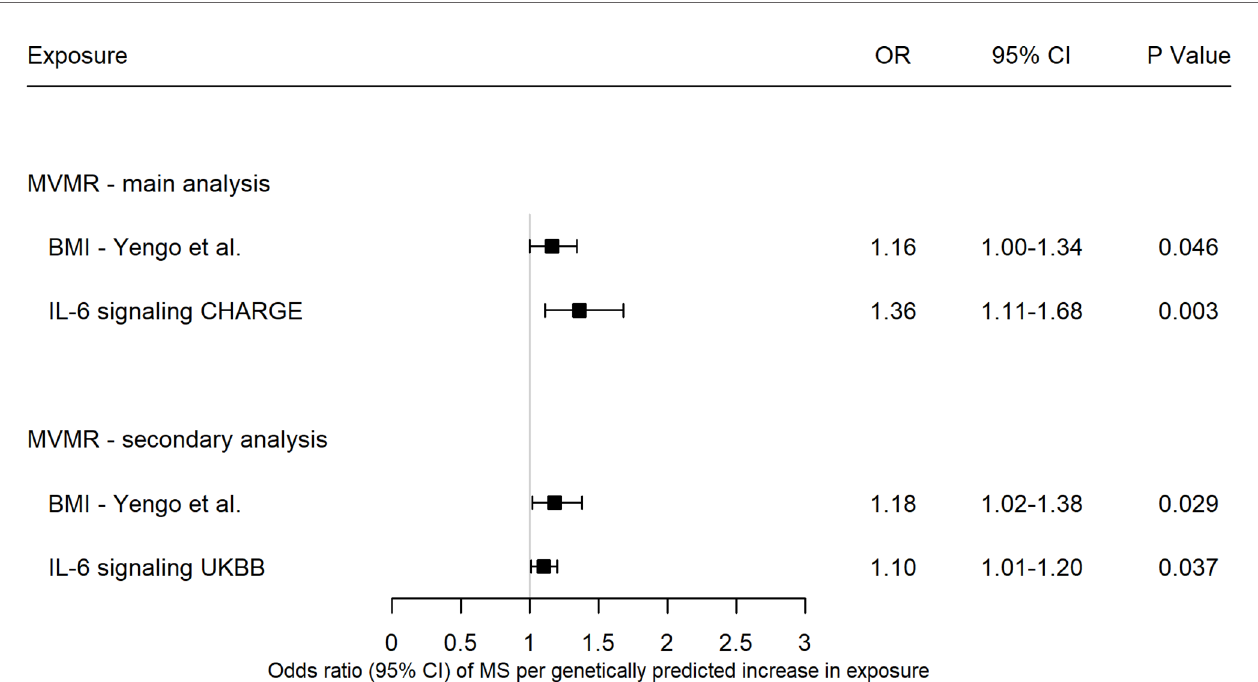
FIGURE 3 | Forest plot of multivariable Mendelian randomization estimates from the inverse-variance weighted method of body mass index and interleukin-6 signaling with risk of multiple sclerosis. Data are displayed as odds ratio (OR) and 95% con fi dence interval (CI) per SD increase in genetically predicted body mass index (BMI) levels, per unit increase in c-reactive protein (CRP) levels for interleukin-6 (IL-6) signaling UKBB, per unit increase in natural-log transformed CRP levels for IL-6 signaling CHARGE. BMI, body mass index; UKBB, UK Biobank; CHARGE, Cohorts for Heart and Aging Research in Genomic Epidemiology; MVMR, multivariable Mendelian